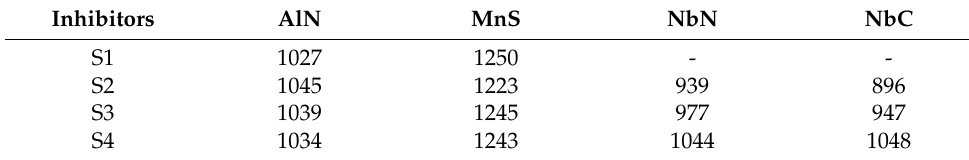
Table 2. Dissolution temperature of inhibitors/ ◦